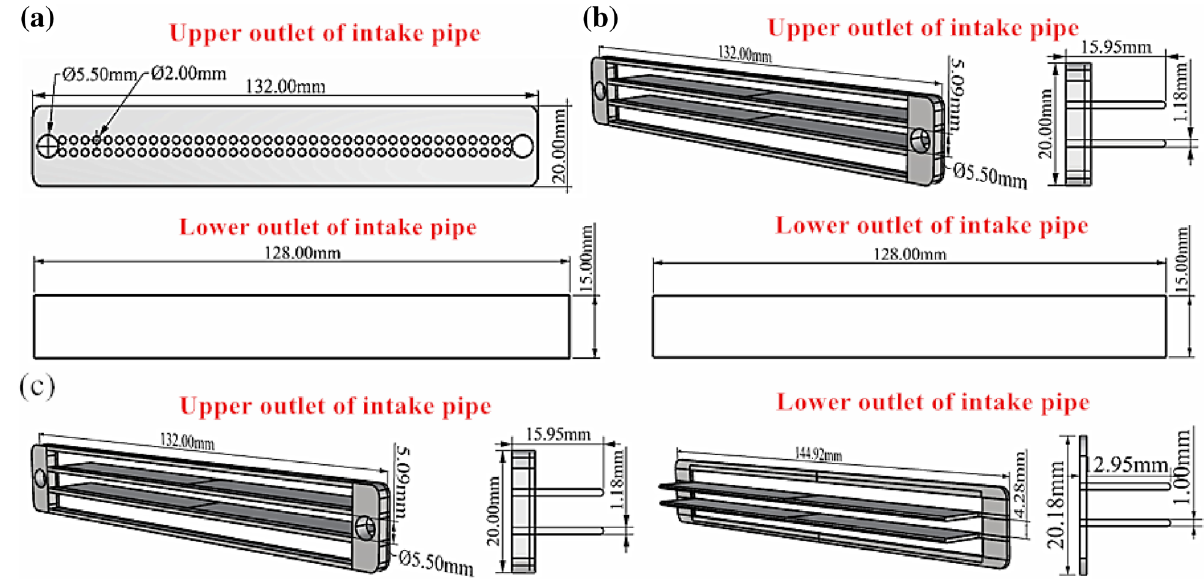
Figure 6. 3D printer inlet pipe outlet end structure: ( a ) Original structure; ( b ) Optimization design 1; ( c ) Optimization design